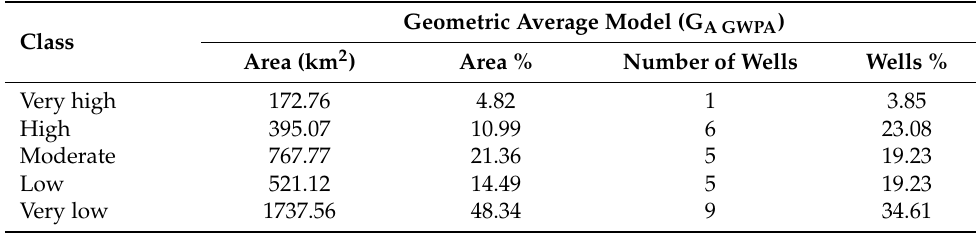
Table 3. The distribution of wells and percentage of areas in potential groundwater zones generated by the G A GWPA